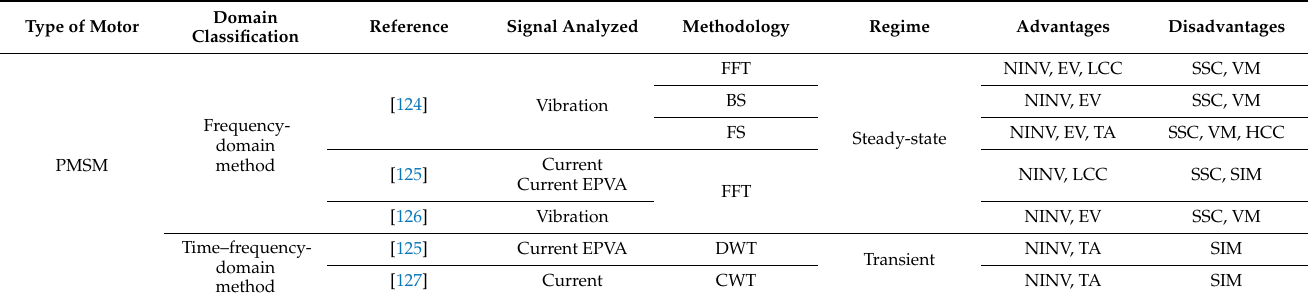
Table 5. Classification of detection methods for rotor unbalance faults in drive systems with PMSMs.